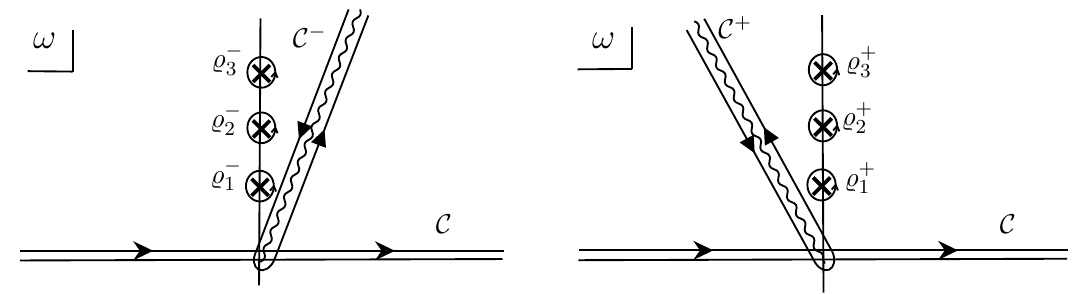
Figure 7. The contour C = ( −∞ , ∞ ) is deformed into either of two ways. The branch cut, represented by the curvy line is moved to either the ray C contour is deformed into C + or C − . In both cases we pick up residues % ± the branch cut